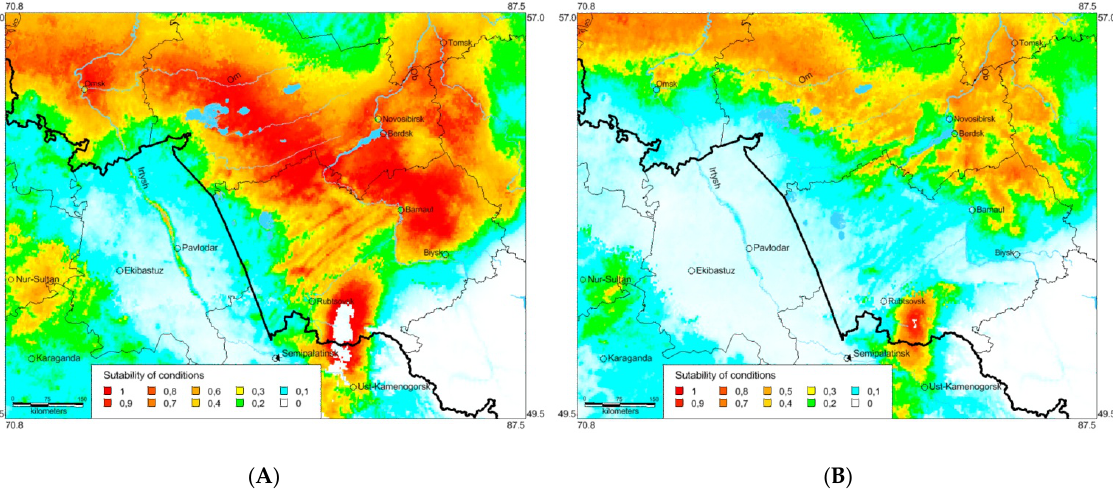
Figure 9. Predicted probabilities of suitable conditions for Oedaleus decorus in the south-eastern part of the West Siberian Plain for 2021–2040 (distribution data from 1961 until 2021 and forecasts of bioclimatic variables from the two global cli- mate models CNRM-ESM2-1 [48,49] ( A ), and MIROC6 [50,51] ( B ), and for the 3–7.0 Shared Socioeconomic Pathway based on high greenhouse gas emisScheme 52. point-wise mean for 20